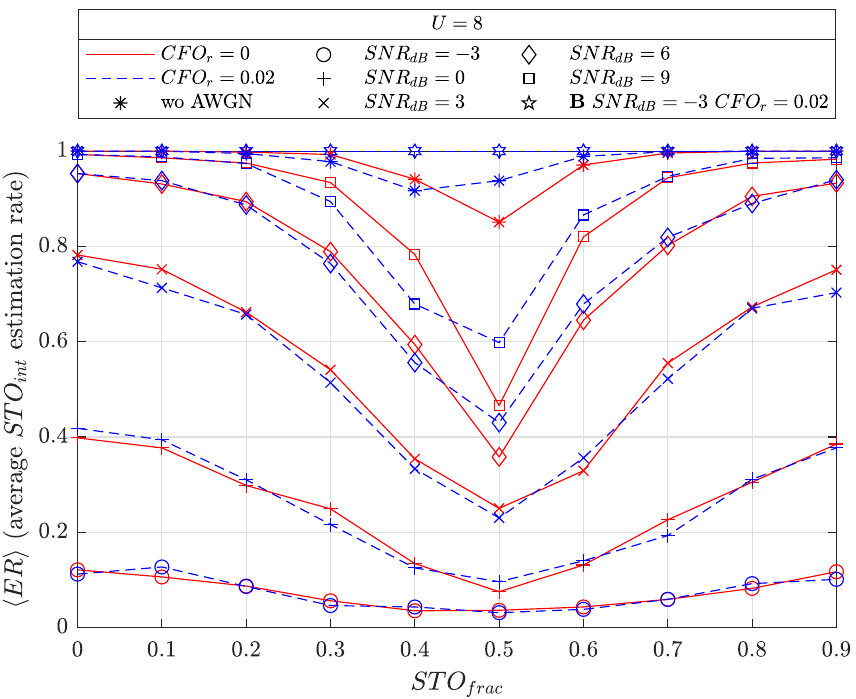
0,0.1, . . . ,0.9 , { } 3,0,3,6,9 for the latter and SF = 7. {− } 3 and CFO frac = −